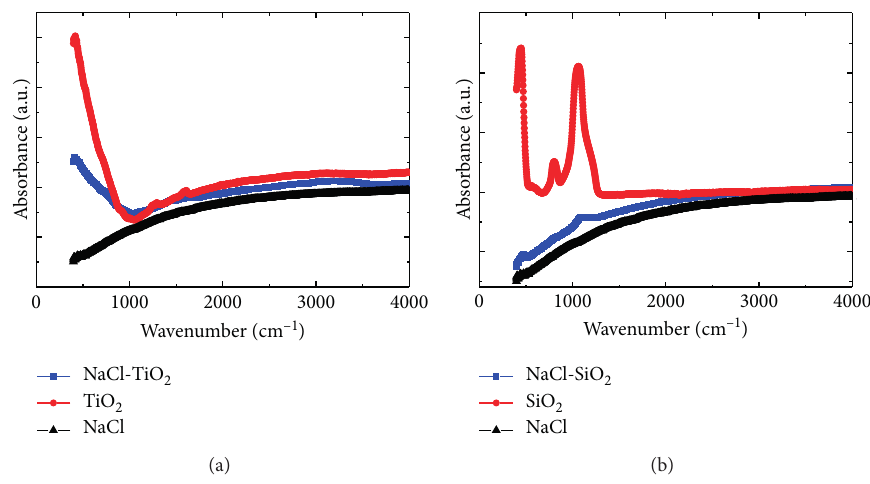
Figure 5: FTIR spectra of (a) NaCl-TiO